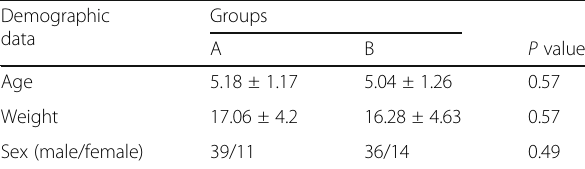
Table 2 Ramsay sedation